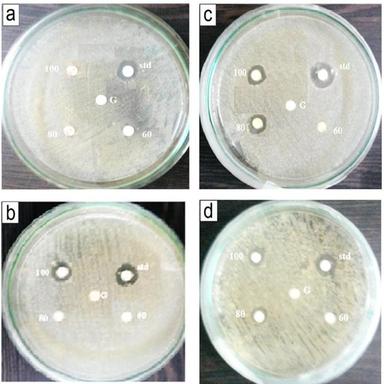
a)S.aureus test for Ti in Hank's solution; b)S. aureus test for ZnO/CS on Ti; c)S. aureus test for ZnO,Ag/CS on Ti. D)S. aureus test for ZnO,Au/CS on Ti.